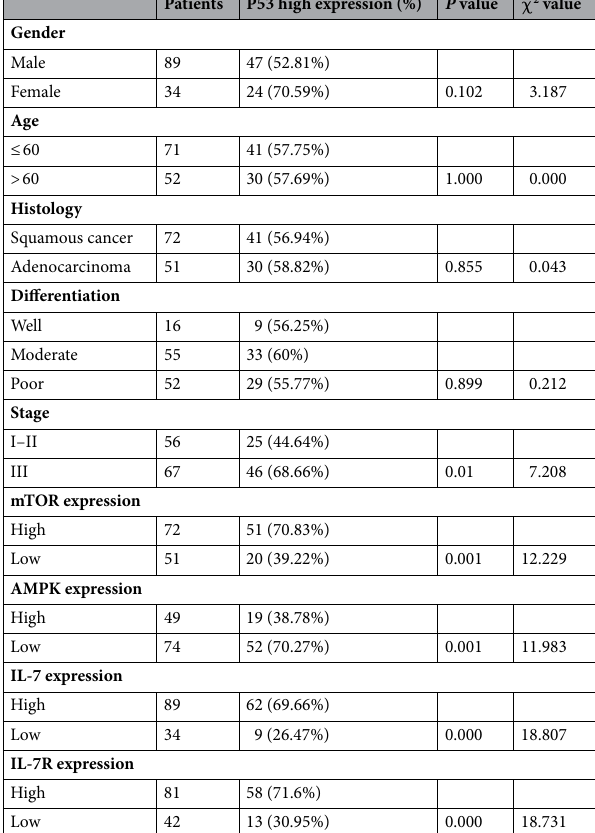
Patients P53 high expression (%) P value χ 2